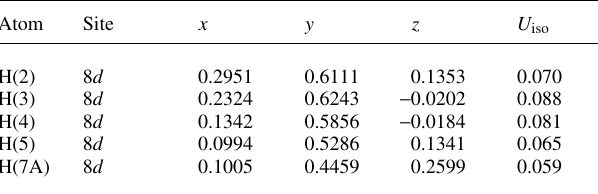
Table 2. Atomic coordinates and displacement parameters (in Å 2 )